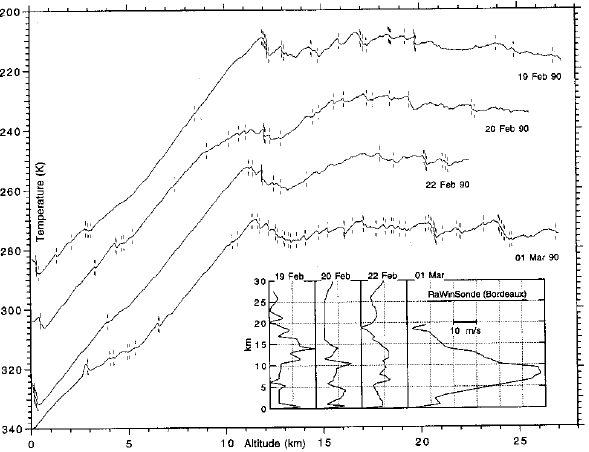
Fig. 14. The four high-resolution temperature profiles measured during the four balloon ascents during the RASCIBA90 campaign (France) and the position of the selected temperature sheets (after Dalaudier et al., 1994). The successive profiles are offset by steps of 20 K. The sheets primarily occur in a group in the region of high static stability. The sheet groups are typically separated by ∼ 1km especially in the profile of 19 February 1990 which is in agreement with the typical separation of the echoing layers seen by high-resolution ST radars (e.g. Tsuda et al.,